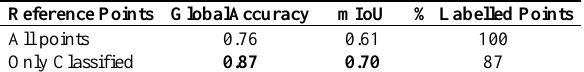
Table 3 . Back-projection results for 1_SC.